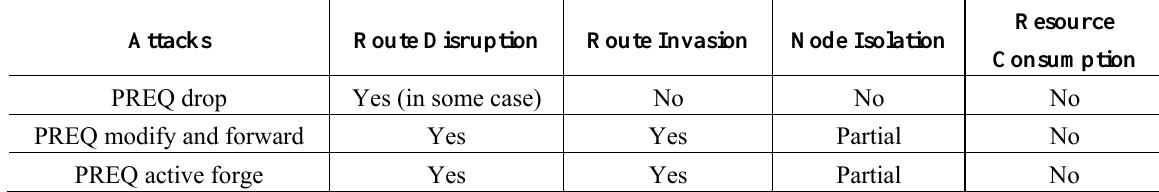
Table 4. Misuse of PREQ messages and achievable misuse goals.